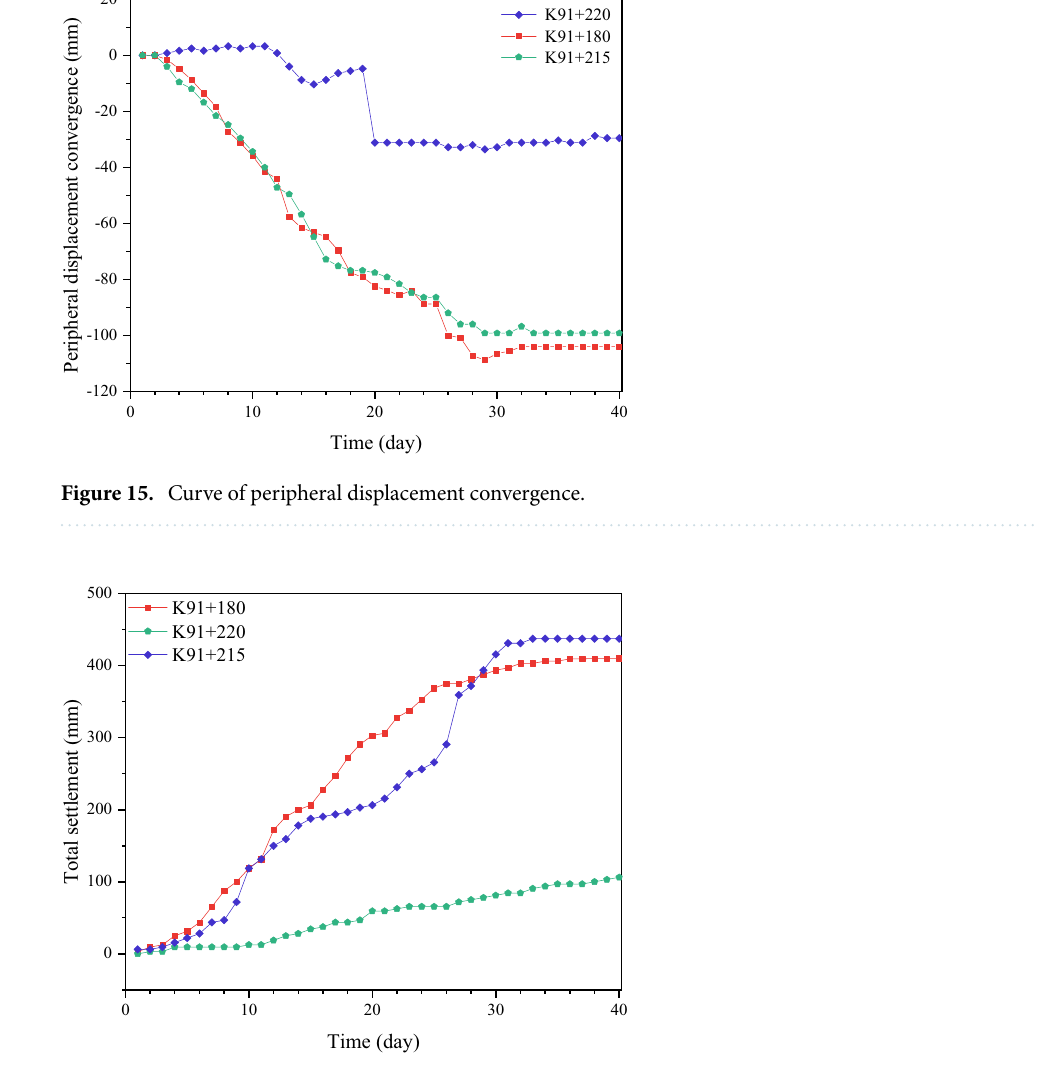
Figure 16. Curve of vault